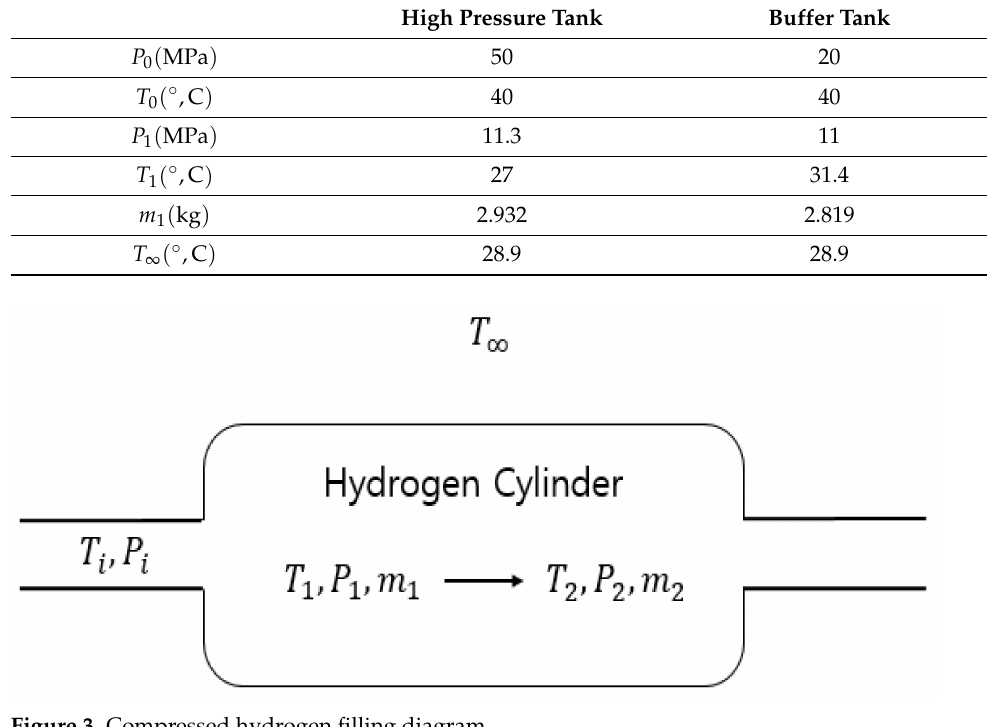
Figure 3. Compressed hydrogen filling